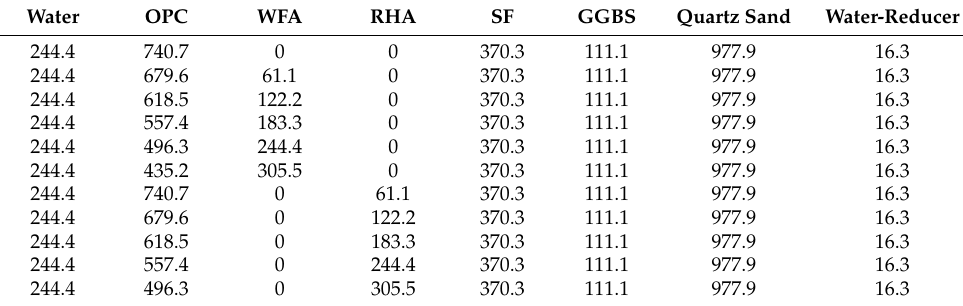
Table 3. The mixing proportions of RPC per 1 cubic meter